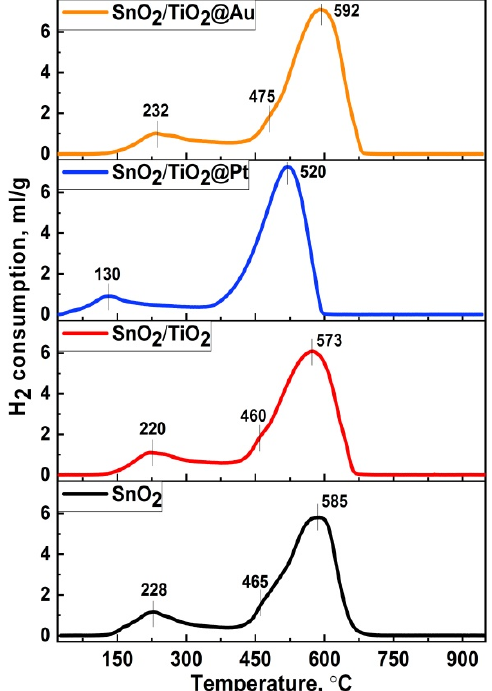
Figure 6. TPR-H 2 spectra of the synthesized samples.